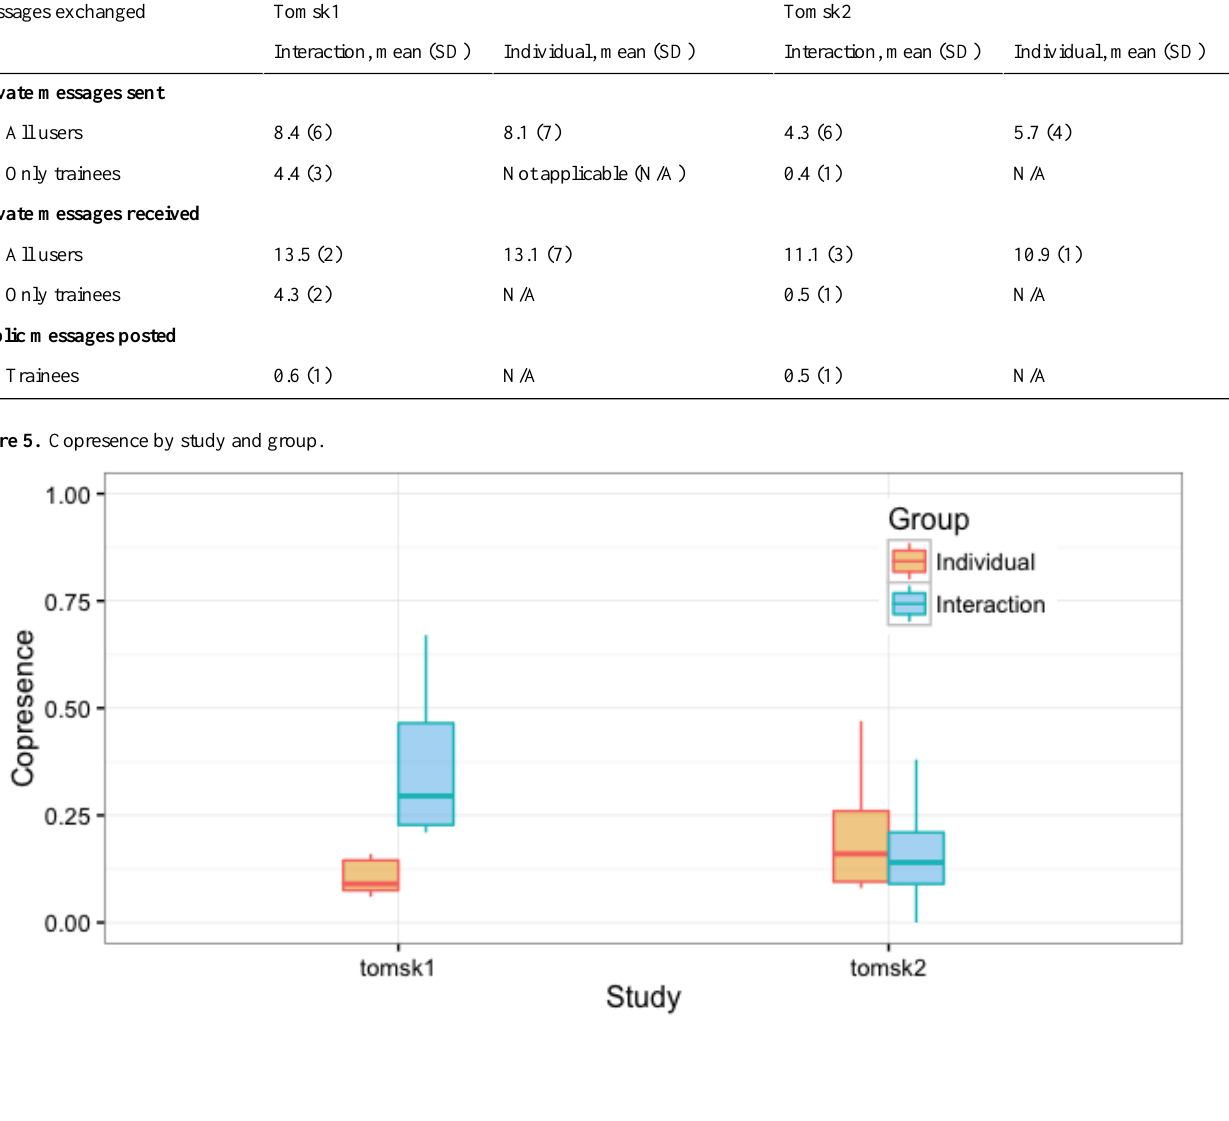
Table 5. Mean (SD) messages exchanged among all users (including the coach) and only trainees. Tomsk2Tomsk1Messages exchanged